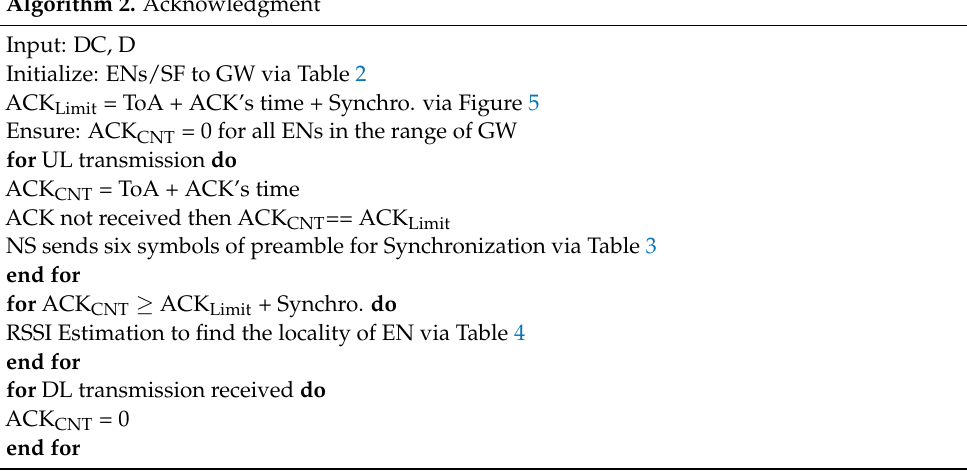
Figure 5. Synchronization acknowledgment. Algorithm 2.